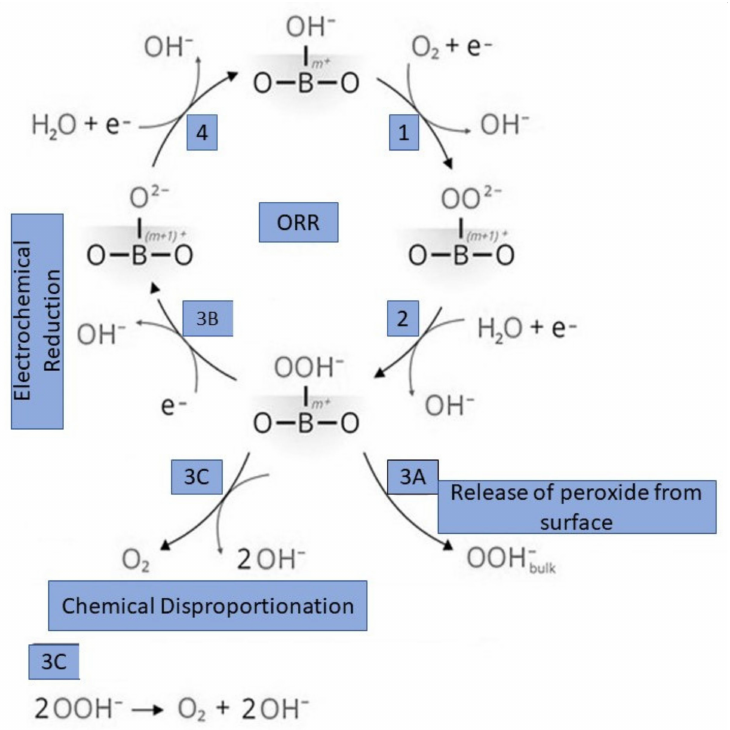
Figure 3. Representation of ORR mechanism in perovskite. ( 1 ) represents the initial step of ORR with adsorption of O 2 on B site, ( 2 ) peroxide formation with addition of proton in O 2 , ( 3A ) release of peroxide from surface, ( 3B ) electrochemical reduction, ( 3C ) chemical disproportionation. (Reprinted with permission from [47]. Copyright 2021, ACS Publications, Open